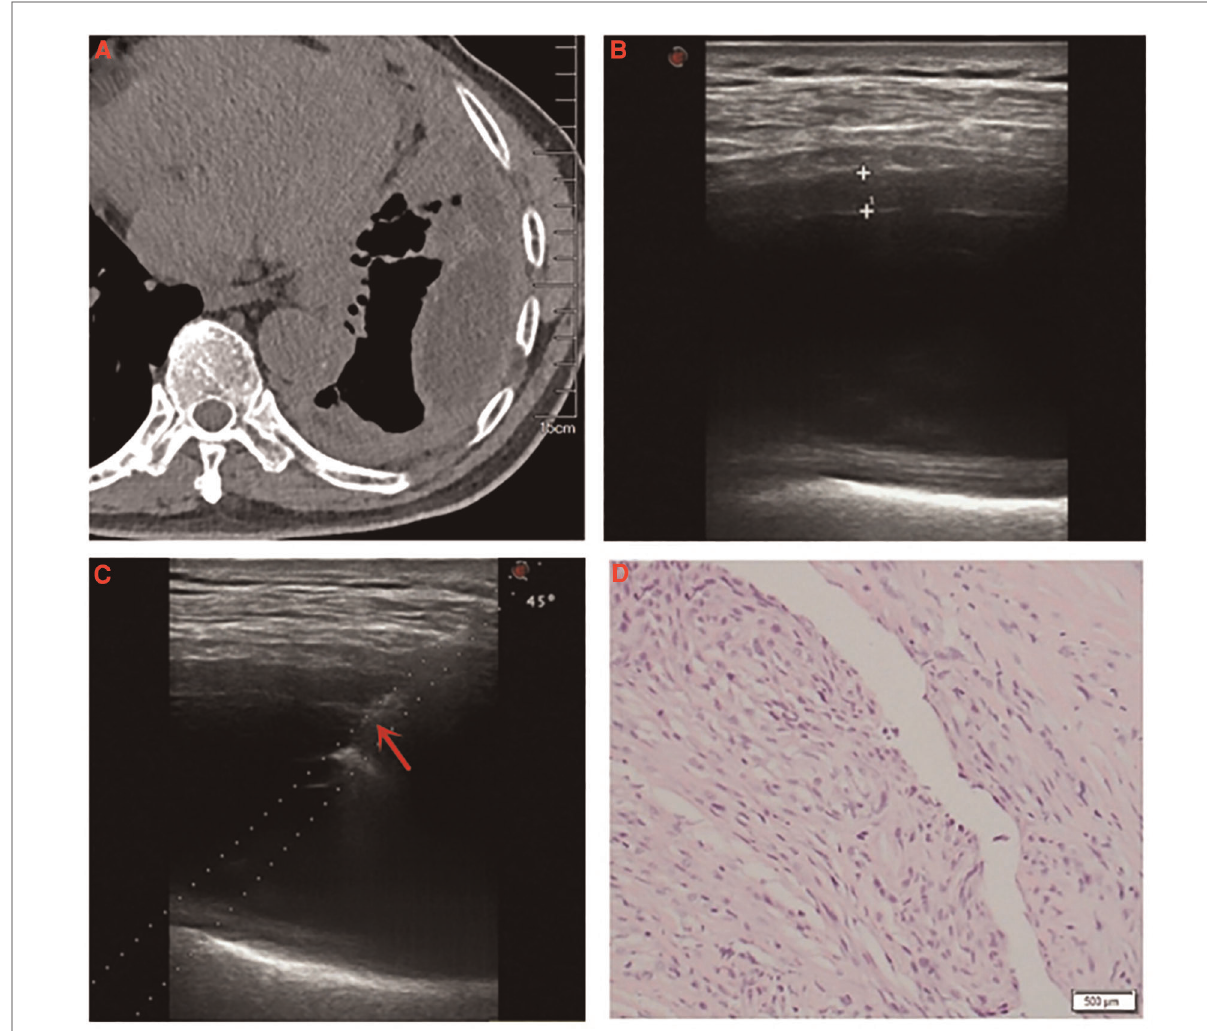
FIGURE 2 A 67-year-old male was diagnosed with pleural mesothelioma. ( A ) Chest computed tomography detected diffuse thickening of pleura with encapsulated effusion in the left thorax. ( B ) Thoracic ultrasound detected the thickness of pleura was measured to be 4.7mm. ( C ) Specimen of thickened pleura was acquired by ultrasound-guided cutting needle biopsy (arrow: biopsy needle). ( D ) Pathological diagnosis: pleural mesothelioma (H&E,